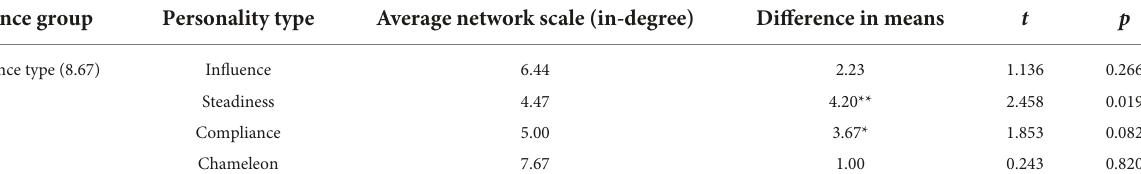
TABLE 4 Average network scale and test results of college students with different personality